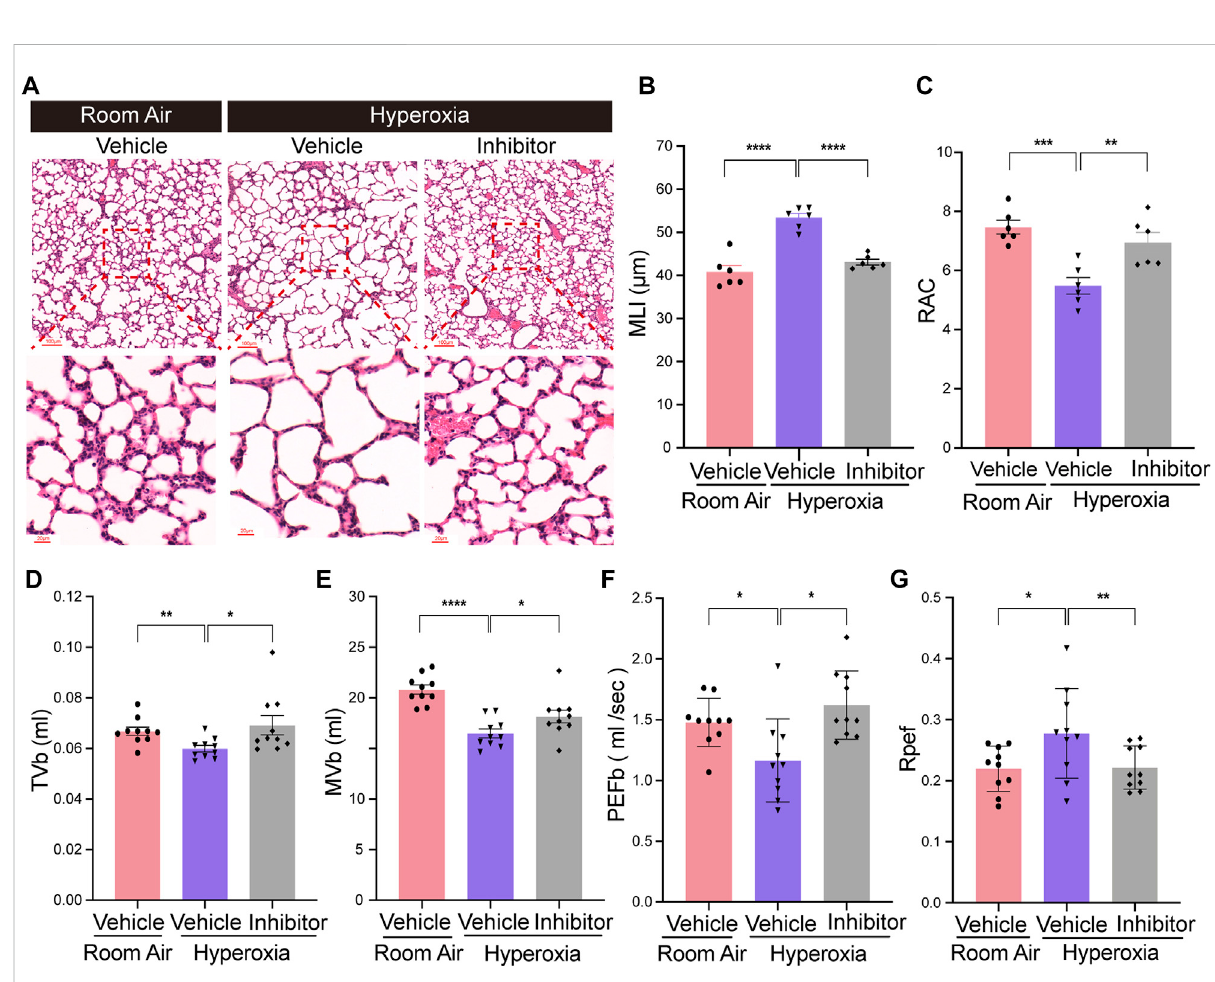
Inhibition of endothelial Fgfr1 improved alveolar developmentand respiratory metrics in neonatal mice in hyperoxia. (A) Representative images of H&E-stained lungs from vehicle or FGFR1 inhibitor treated mice. The top panel shows low-magni fi cation (scale bar = 100 μ m) images, and the bottom panel shows higher-magni fi cation (scale bar = 20 μ m) images. (B,C) Quanti fi cation of MLI (B) and RAC (C) based on the data in (A). Data are shown asmeans±SEMs. n= 6pergroup. ** p < 0.01, *** p < 0.001,**** p < 0.0001. (D – G) Resultsof respiratorymetrics measurement. Dataare shown as means ± SEMs. n = 10 per group. * p < 0.05, ** p < 0.01, **** p <